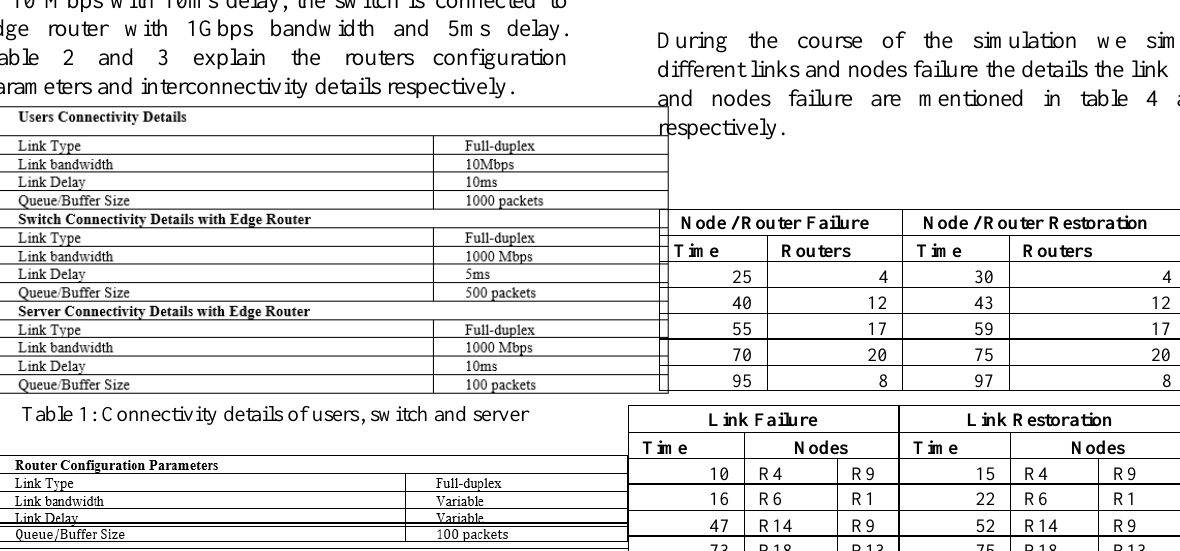
Table 5: Showing nodes failure and restoration